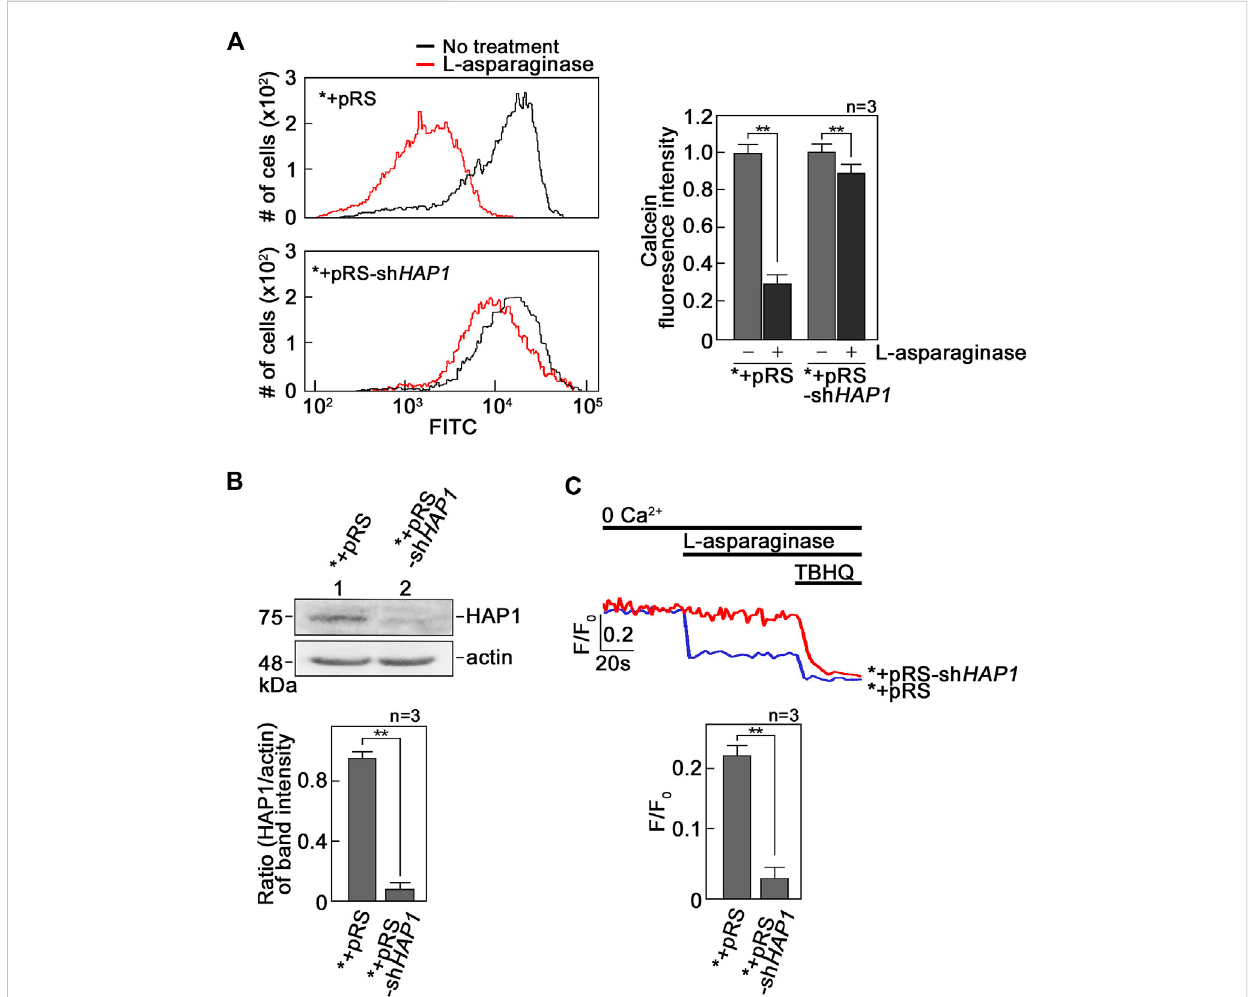
FIGURE 1 L-asparaginase-induced IP3R-mediated ER Ca 2+ release causes mPTP formation. (A) SEM cells (*) infected with retrovirus carrying an empty pRS vector (*+pRS) or pRS-sh HAP1 (*+pRS-sh HAP1 ) and loaded with calcein-AM were stimulated with L-asparaginase. Cells were then treated with CoCl 2 and subjected to fl ow cytometry analysis. Data on the left are from one of three independent experiments showing similar results. The chart on the right shows quantitative analysis of the relative calcein fl uorescence in *+pRS and *+pRS-sh HAP1 cells treated (or untreated) with L-asparaginase. Readings fromuntreatedcellswerenormalizedto1.0.Values aremeans±SEM fromthethreeindependent experiments (n=3).** p < 0.05. (B) Lysatesof *+pRS and *+pRS-sh HAP1 cells were resolved by SDS-PAGE and immunoblotted for HAP1. Blots (upper panel) shown represent one of three blots with similar results. The actin blot serves as loading control. The bottom panel shows ratios of HAP1 vs. actin levels based on densitometric analysis of blots from the three independent experiments ( n = 3) using the NIH ImageJ 1.61 software. Actin values were normalized to 1.0. ** p < 0.05. (C) *+pRS and *+pRS-sh HAP1 cells (0.5 × 10 6 cells) loaded with Mag-Fluo-4 AM, an ER Ca 2+ probe (Takahashi et al., 1999), then treated with L-asparaginase were analyzedfor ERCa 2+ release byspectro fl uorometry.Tracingsontheupperpanel arefromoneofthreeindependentexperiments showingsimilar results. The chart (bottom panel) shows ER Ca 2+ release in *+pRS and *+pRS-sh HAP1 cells stimulated with L-asparaginase. Values are means ± SEM from the three independent experiments ( n = 3). ** p <